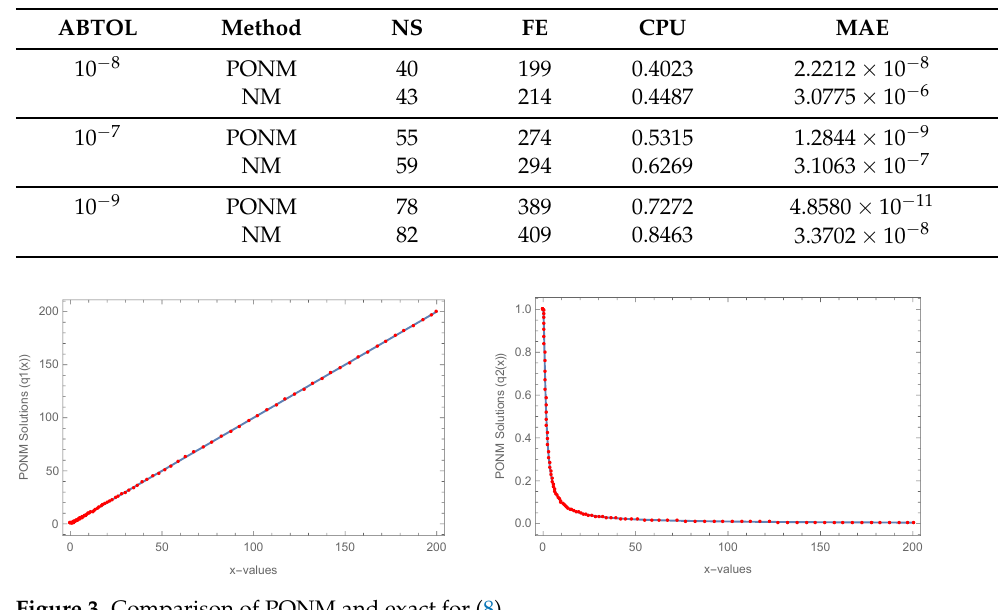
Figure 3. Comparison of PONM and exact for